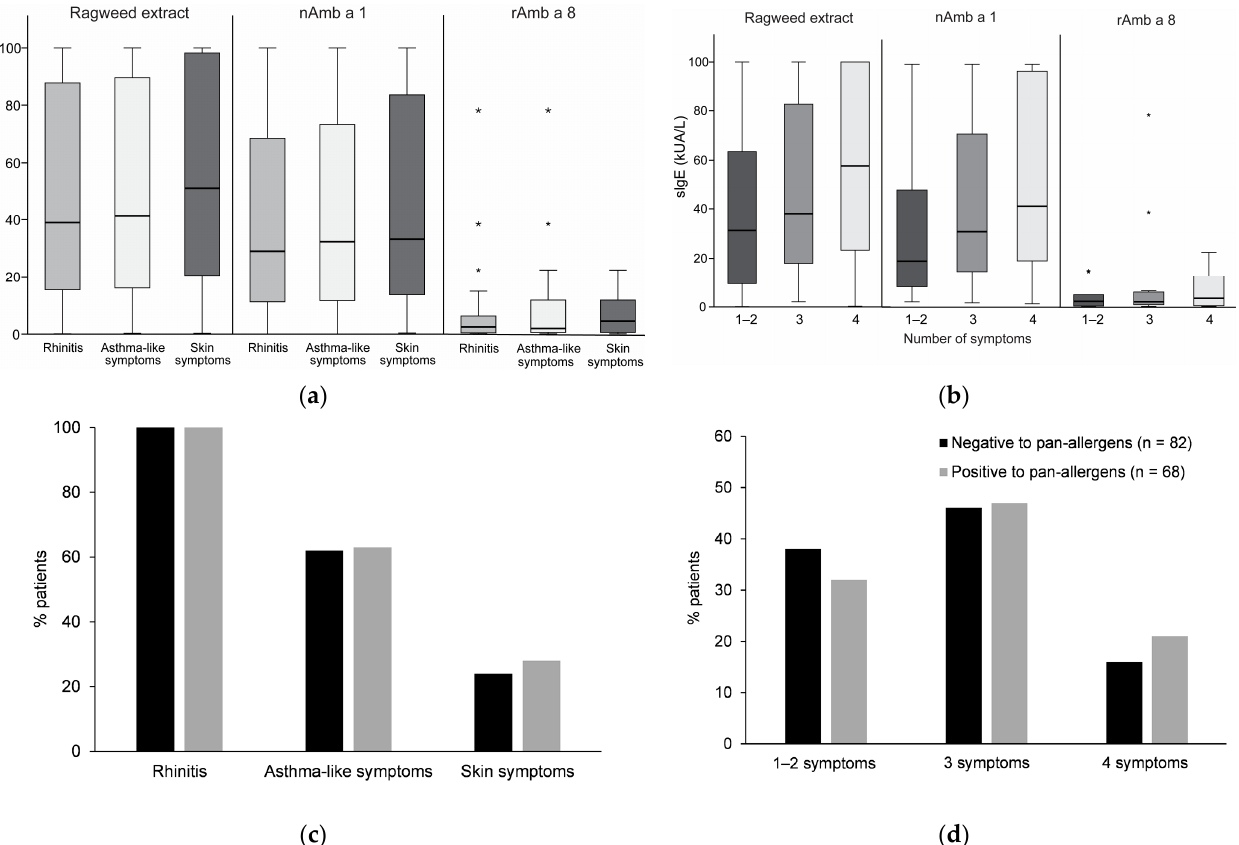
Figure 5. Association of the IgE response with clinical symptoms: patients show specific IgE levels to ragweed extract, Amb a 1 and Amb a 8 (x-axis) in relation to ( a ) prevalence of different symptoms and ( b ) the number of symptoms. Results are expressed as kUA/L (y-axis) (median = horizontal bars, boxes = IQR, whiskers = minimum and maximum not exceeding IQR; asterisks represent outliers exceeding 3.0 x IQR). ( c ) Prevalence of different symptoms and ( d ) number of symptoms (x-axis) in relation to reactivity towards any of the pan-allergens Amb a 8, Amb a 9 and Amb a 10 was expressed as percentage of patients (y-axis).